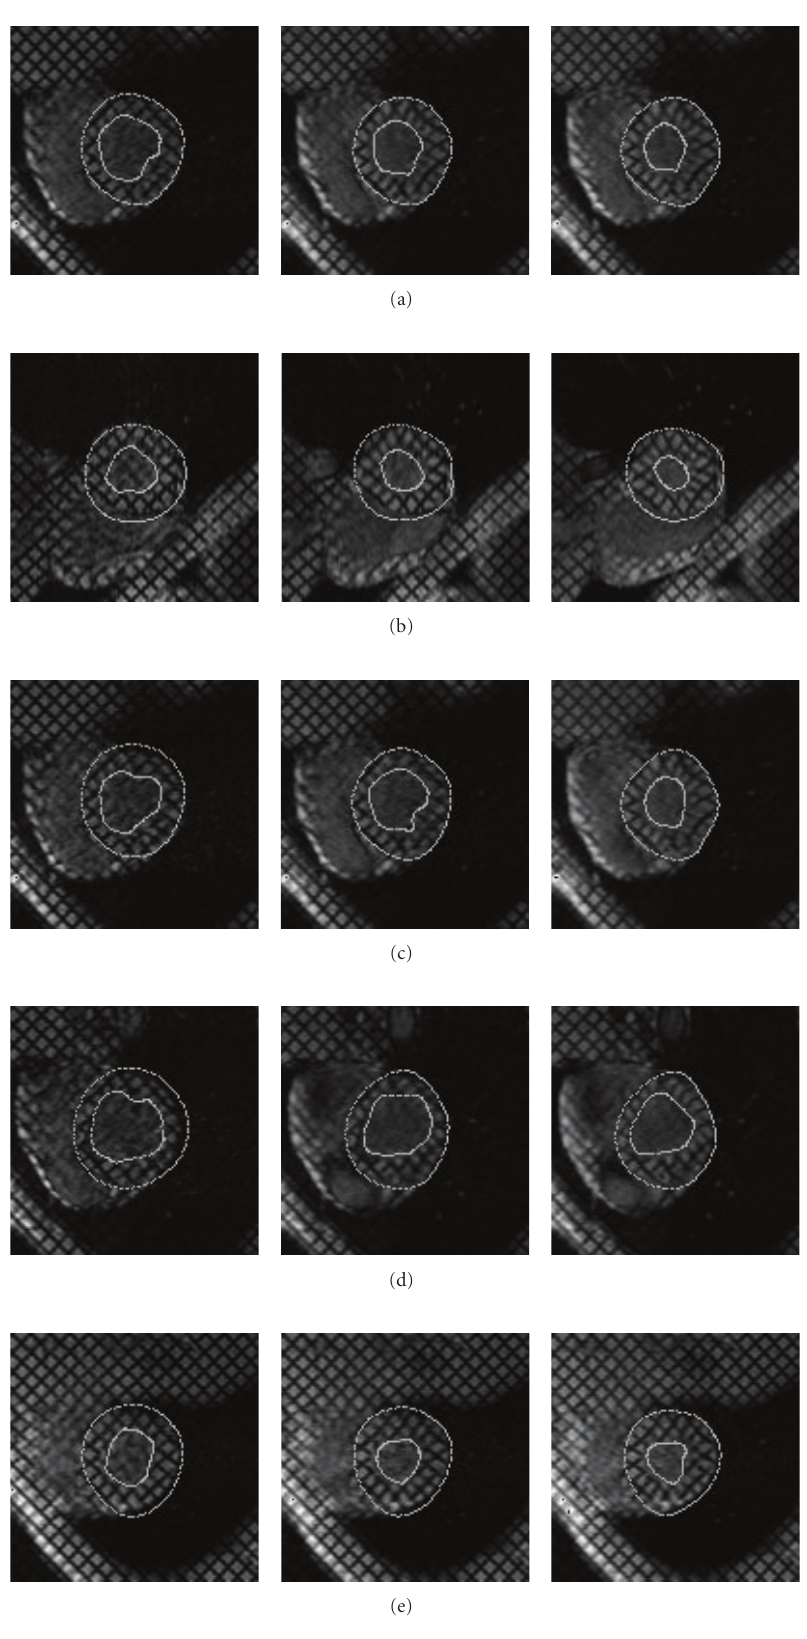
Figure 8: Detection and tracking of endocardial and epicardial boundaries on SA sequences all along diastole for 5 di ff erent